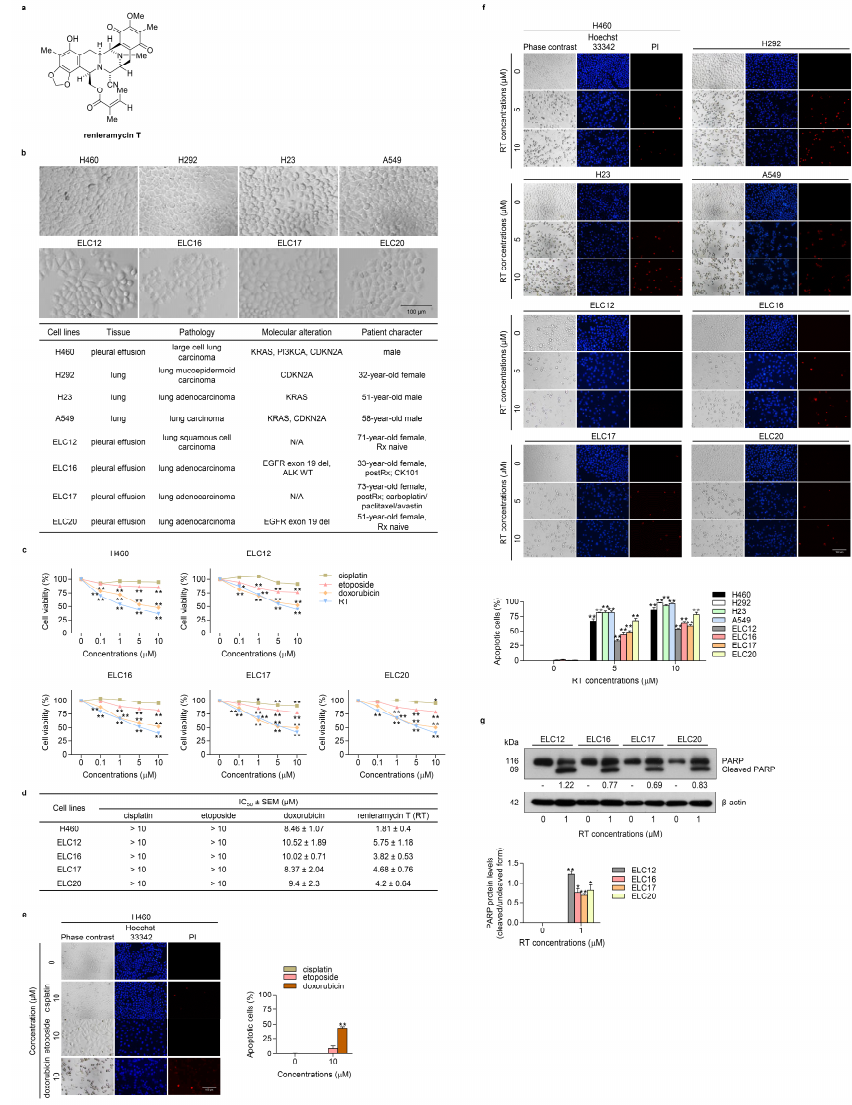
Figure 1. E ff ects of renieramycin T (RT) on cell viability and apoptotic cell death in non-small cell lung cancer (NSCLC) cell lines (H460, H292, H23, and A549) and patient-derived primary cancer cell lines (ELC12, ELC16, ELC17, and ELC20). ( a ) The structure of RT. ( b ) The morphology of NSCLC and patient-derived primary cancer cell lines and their molecular characteristics. ( c ) H460, ELC12, ELC16, ELC17, and ELC20 cells were seeded and treated with 0–25 µ M of RT or chemotherapeutic drugs (cisplatin, etoposide, and doxorubicin) for 24 h. Then, the MTT assay was performed to determine the percentages of cell viability. ( d ) The IC 50 in all cells was calculated in comparison to the untreated control. ( e–f ) Cells were seeded and treated with 0–10 µ M of RT or chemotherapeutic drugs (cisplatin, etoposide, and doxorubicin) for 24 h before adding Hoechst 33342 and PI to stain the cell nucleuses. Images were detected by using a fluorescence microscope and the percentages of nuclear-fragmented and propidium iodide (PI)-positive cells were calculated. ( g ) ELC12, ELC16, ELC17, and ELC20 cells were treated with 0–1 µ M of RT for 24 h. Western blot analysis was performed to detect the PARP and cleaved PARP protein levels. The blots were reprobed with β -actin to confirm an equal loading of each of the protein samples and densitometry was used to calculate the protein expression levels. Densitometric values of protein levels were presented as the fold changes relative to uncleaved form of the protein. Data represent the mean ± SEM ( n = 3) (* 0.01 ≤ p < 0.05, ** p < 0.01, compared with the untreated control). Gene symbols: KRAS (Kirsten Rat Sarcoma Viral Oncogene Homolog), PI3KCA (Phosphatidylinositol-4, 5-Bisphosphate 3-Kinase Catalytic Subunit Alpha), CDKN2A (Cyclin Dependent Kinase Inhibitor 2A), EGFR (Epidermal Growth Factor Receptor), ALK (Anaplastic Lymphoma Receptor Tyrosine Kinase). Abbreviations: N / A (not available), del (deletion), WT (wild type), Rx